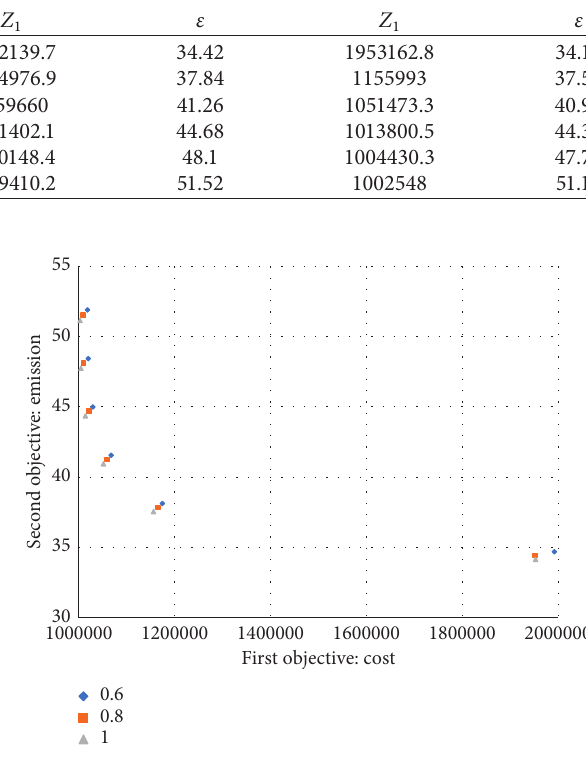
Figure 3: Pareto solution of the first sample problem for α � 0.6, 0.8, and 1.